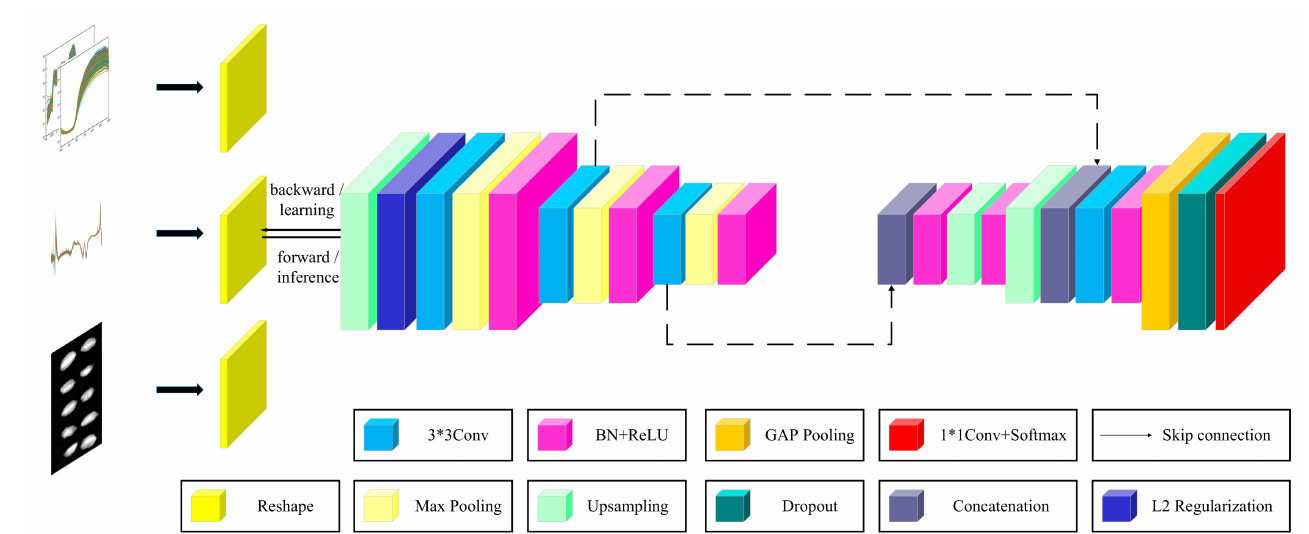
Figure 2. MRes-FCN+ based multi-task network architecture. Residual blocks help solve the problems of gradient disappearance and gradient explosion [16]. The difference between them and the regular block is shown in Figure 3. The proposed network consisted of a basic core network and an attention module, which could capture global information.